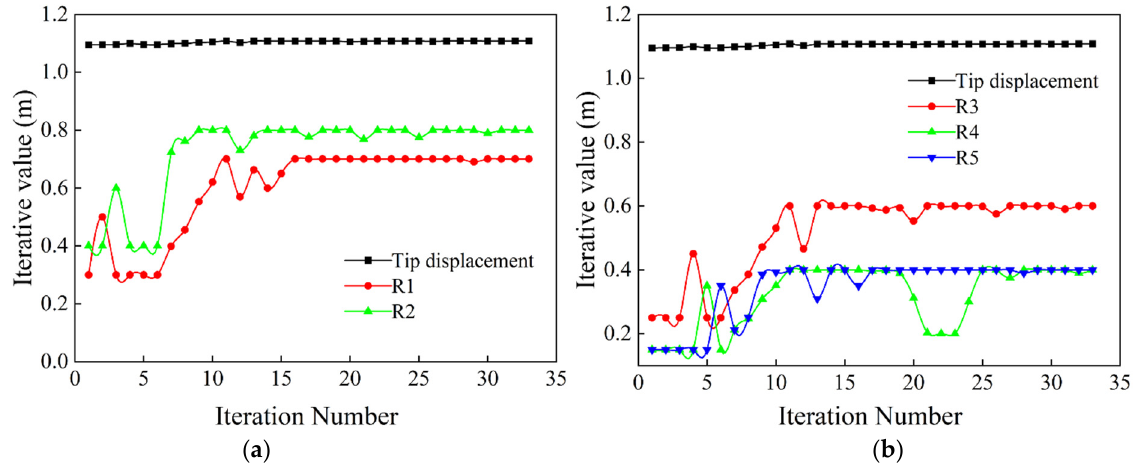
Figure 6. Design variables during optimization: ( a ) values of tip displacement, R1, and R2 during iteration; ( b ) values of tip displacement, R3, R4, and R5 during iteration.